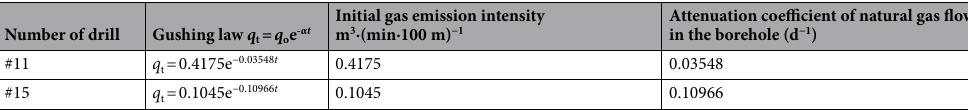
Table 3. 1312 Results of natural gas gushing from a 100-m borehole of the working face.